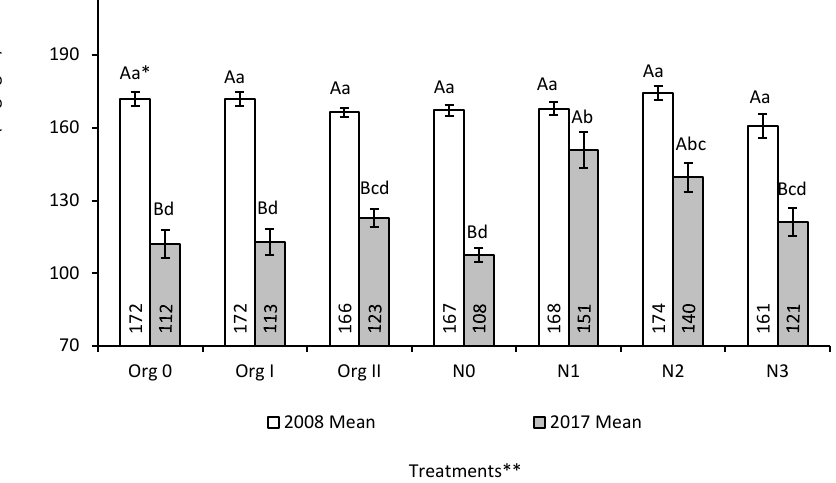
Fig. 5. Plant available K content (mg kg ‒1 ) in the soil at the beginning of the field trial and after ten years. 2008 Mean: F =1.268, p =0.276; 2017 Mean: F =8.215, p <0.001; (6, 133) (6, 133) *different large letters indicate a significant difference between years, and different small letters indicate the difference between treatments in a given year; ** See explanations under Figure 1